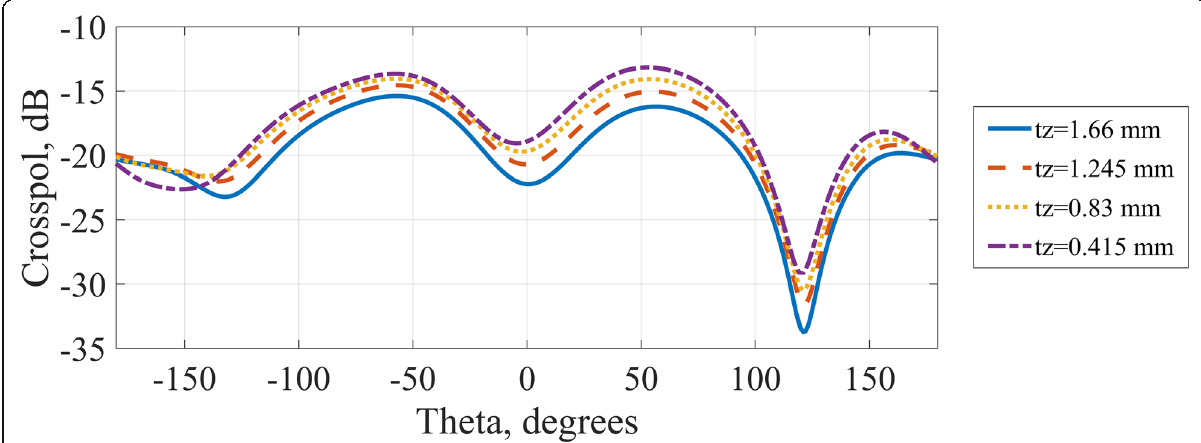
Fig. 7 Effect of the variation of tz (transition length) on cross-polar level for Phi0